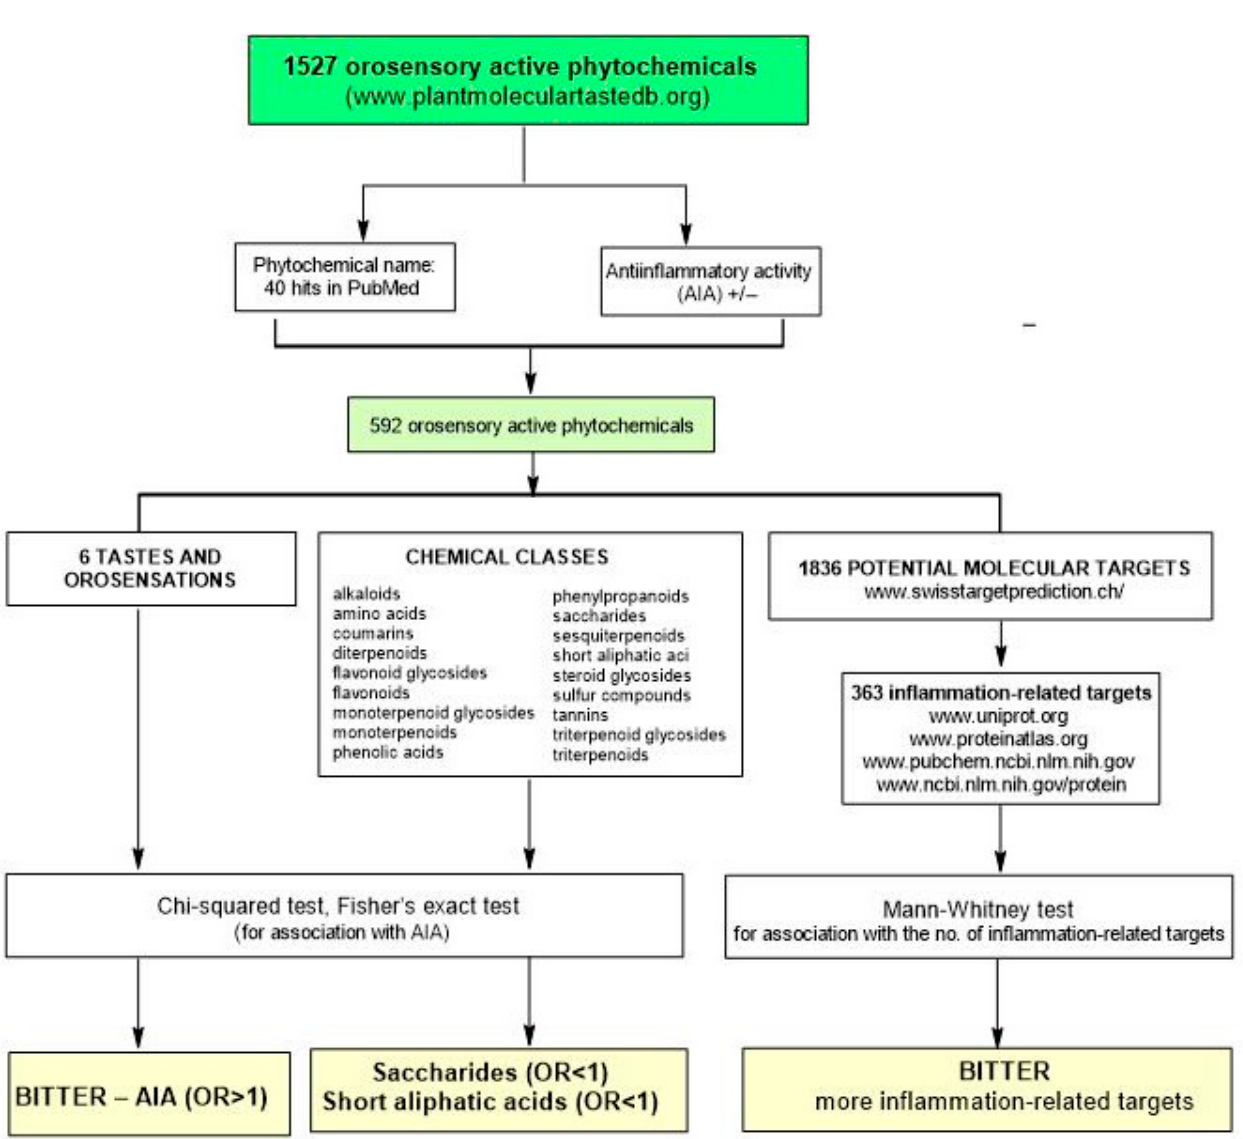
Figure 1. Flowchart outlining the steps of data preparation and statistical analysis. Table 5. The 2 × 2 table used for performing Chi-square test (AIA = anti-inflammatory activity).